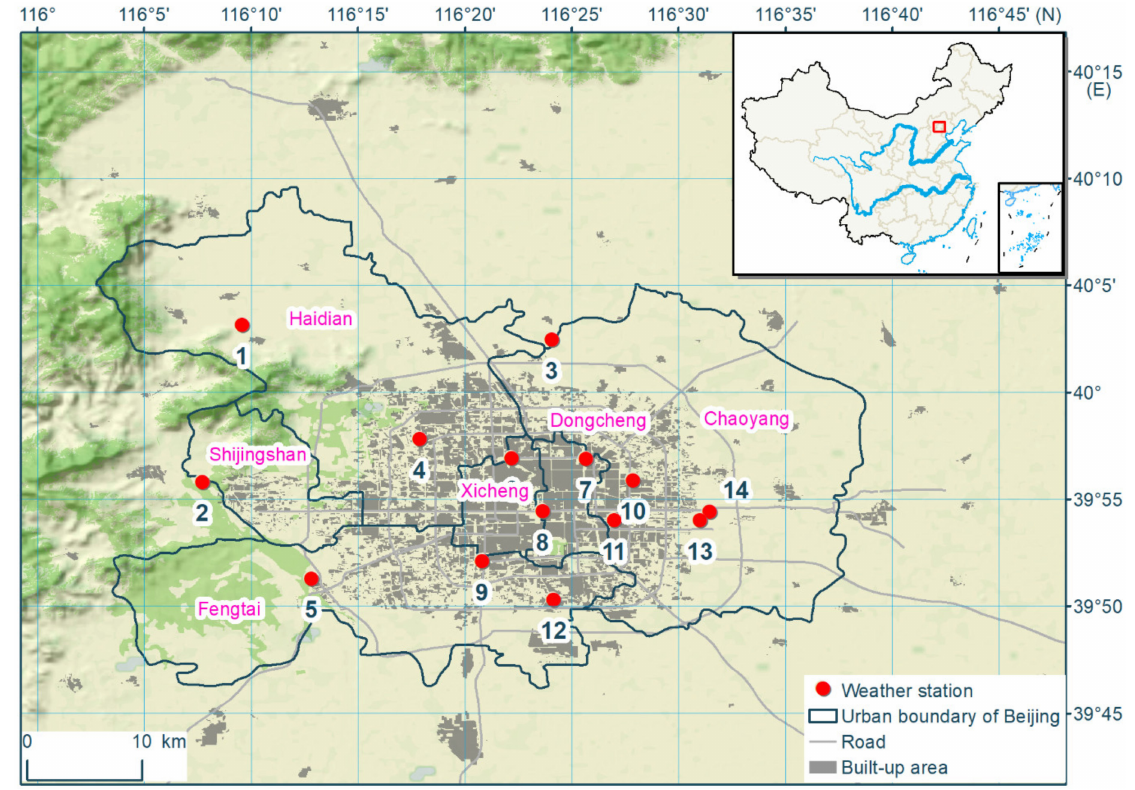
Figure 1. Study area.